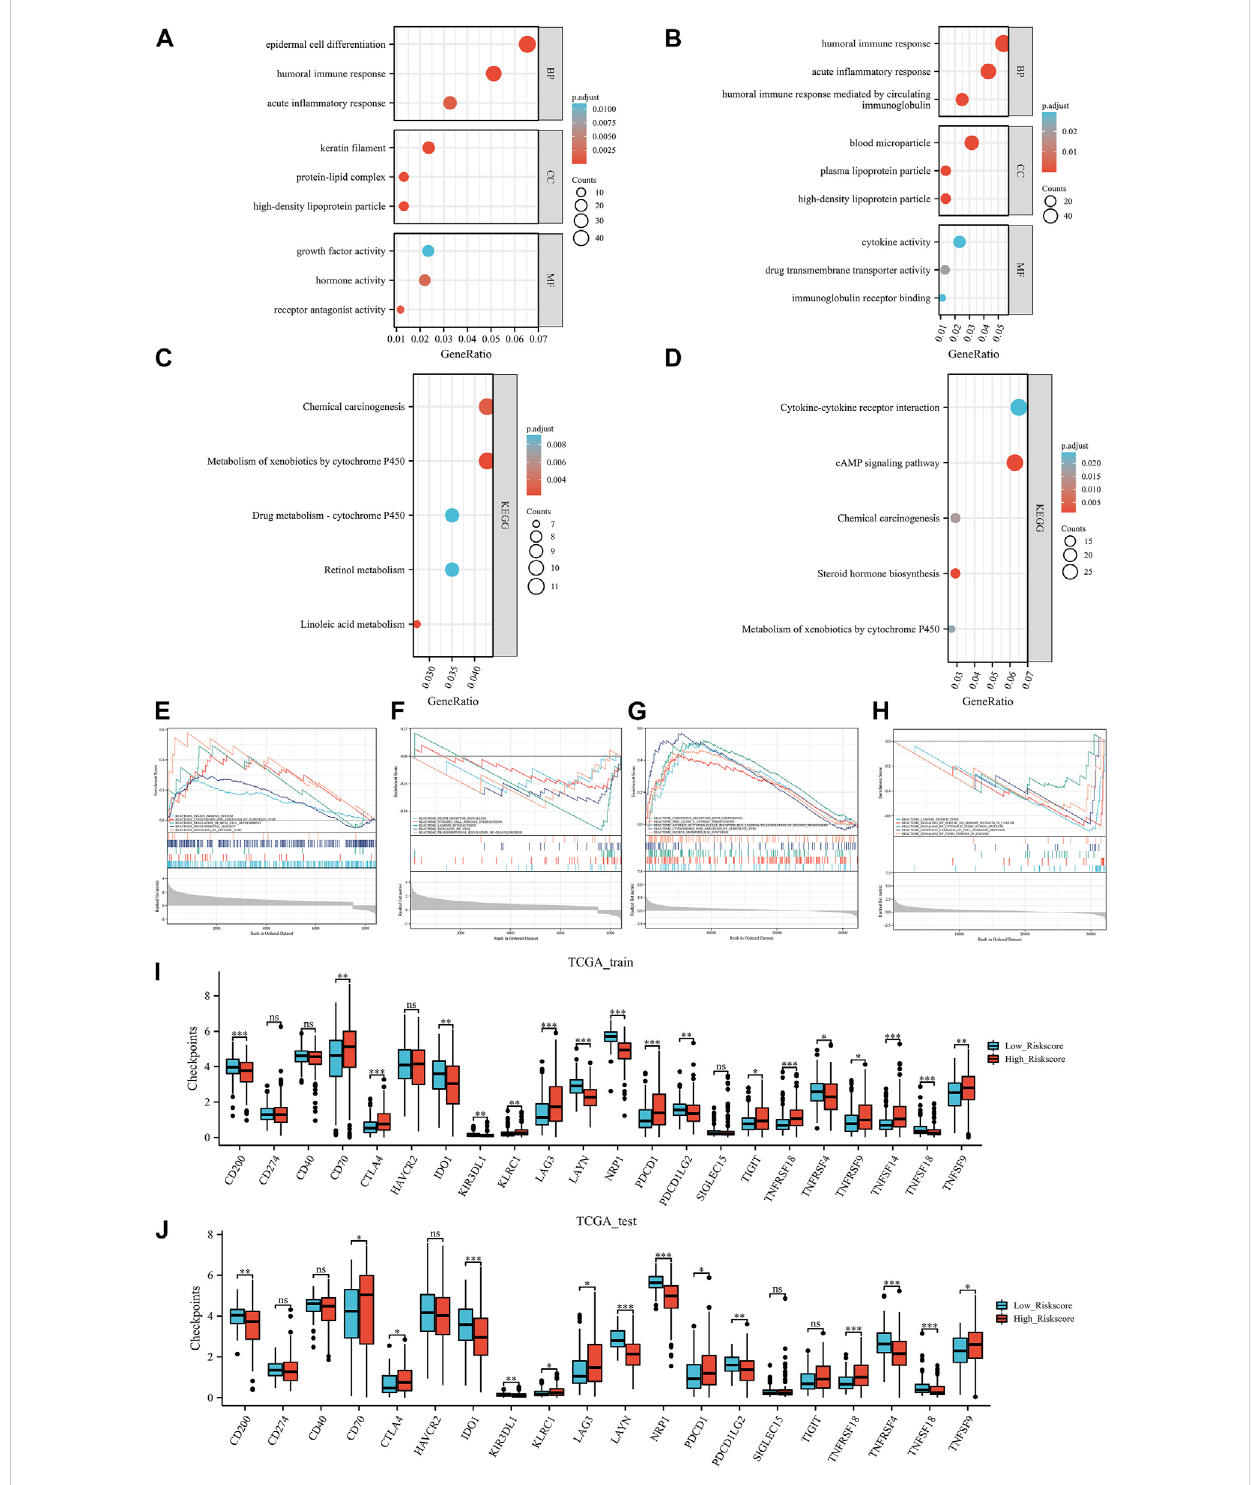
FIGURE 5 Functional analysis: the Gene Ontology results of TCGA training group (A) and TCGA test group (B) , Kyoto Encyclopedia of Genes and Genomes results of TCGA training group (C) and TCGA test group (D) , Gene Set Enrichment Analysis results TCGA training group (E, F) and TCGA test group (G, H) . Immune checkpoint results of the TCGA training group (I) and TCGA test group (J) . Ns, p ≥ 0.05; *, p < 0.05; **, p < 0.01; ***, p <